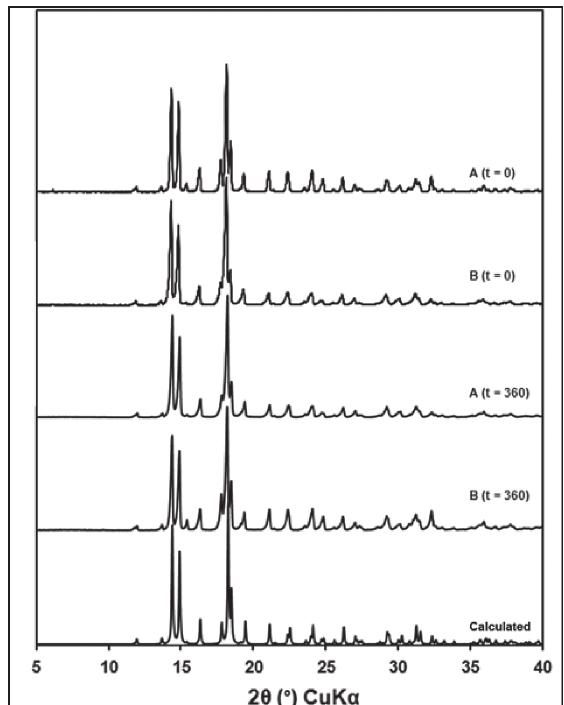
FIGURE 3 - Diffraction patterns of prednisone samples A and B at zero and 360 days of the stability study and the simulated pattern.